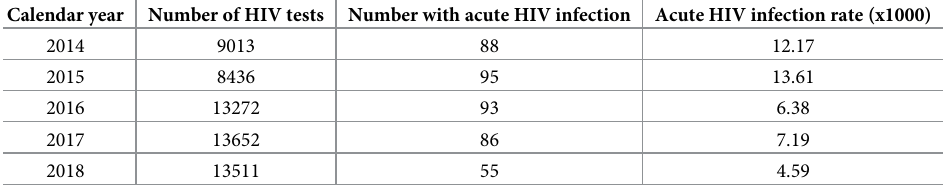
Table 2. Acute HIV infection rate among men who have sex with men attending HIV testing and counseling ser- vices at the Thai Red Cross Anonymous Clinic, Bangkok, 2014–2018.